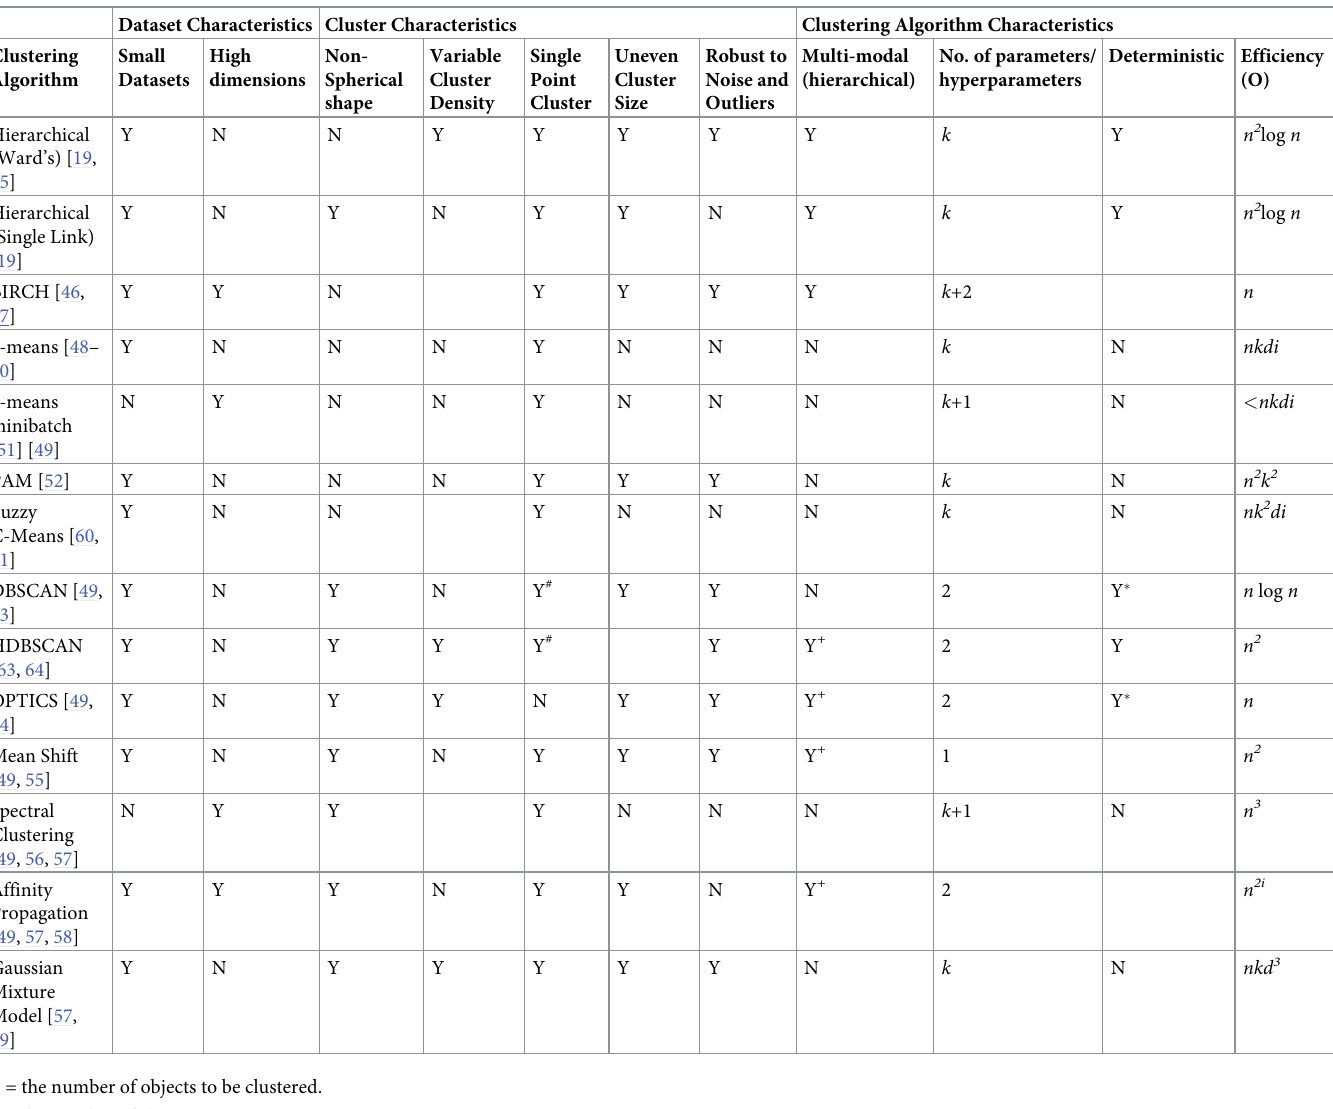
Table 3. Comparative matrix of identified characteristics vs. candidate clustering algorithms. Dataset Characteristics Cluster